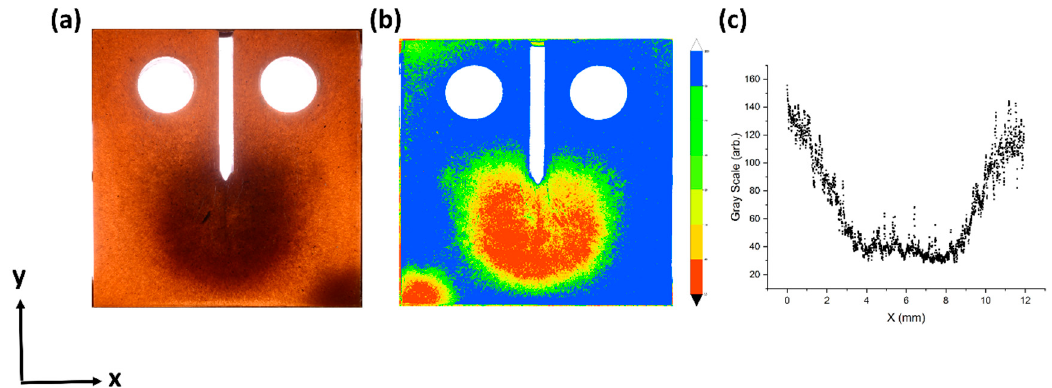
Figure 5. Concentration of fibers in the crack vicinity. ( a ) A photograph of compact-tension specimen cured under the influence of concentrating magnets (setup 1). ( b ) A light intensity contour map of the specimen photograph highlighting the fiber distribution. ( c ) A profile of the photograph greyscale values (0—black, 255—white) along the X-axis taken a few millimeters below the crack-tip. Fiber analysis using Computed Tomography confirmed alignment of the fibers parallel to the Z -axis for composites cured in setup 1 (concentration magnets), and alignment of the fibers parallel to the X -axis for composites cured in setup 2 and 3 (unidirectional orientation using a solenoid and X -axis for each configuration was computed according to Equation (3) and given in Table 3. The fiber orientation in the composites is visualized in Figure